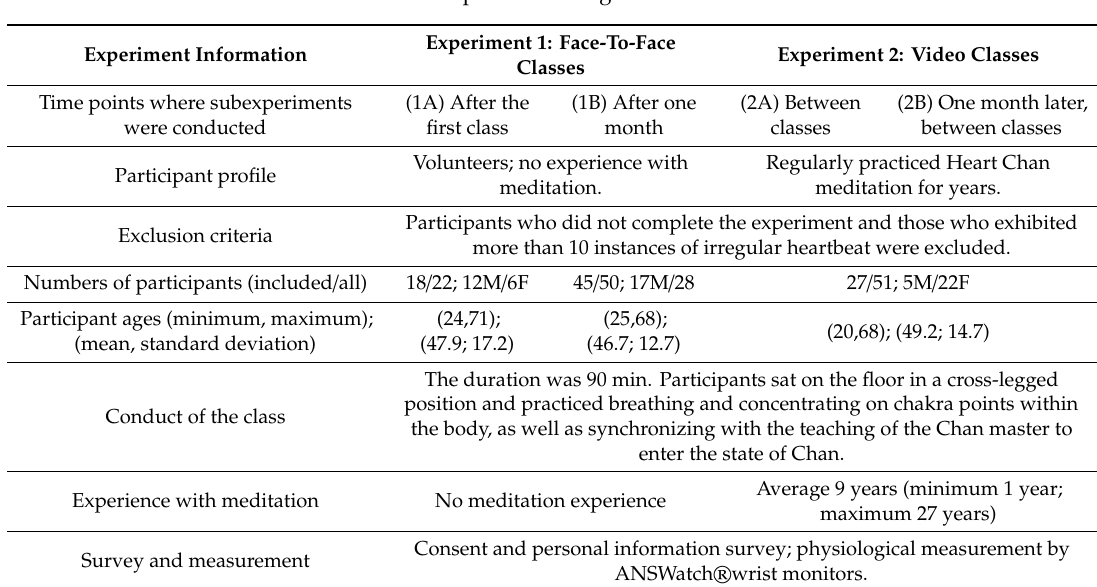
Table 2. Experiment design